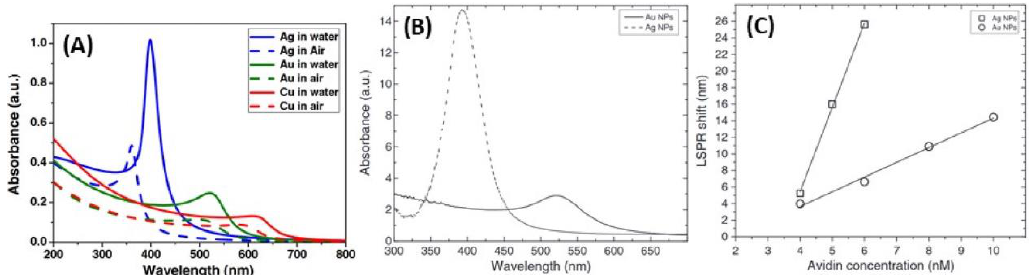
Figure 15. ( A ) Calculated extinction spectra of Ag, Au and Cu spherical NPs (20 nm) in different media. ( B ) Experimental extinction spectra of Ag and Au spherical NPs (10 nm) and ( C ) experimental